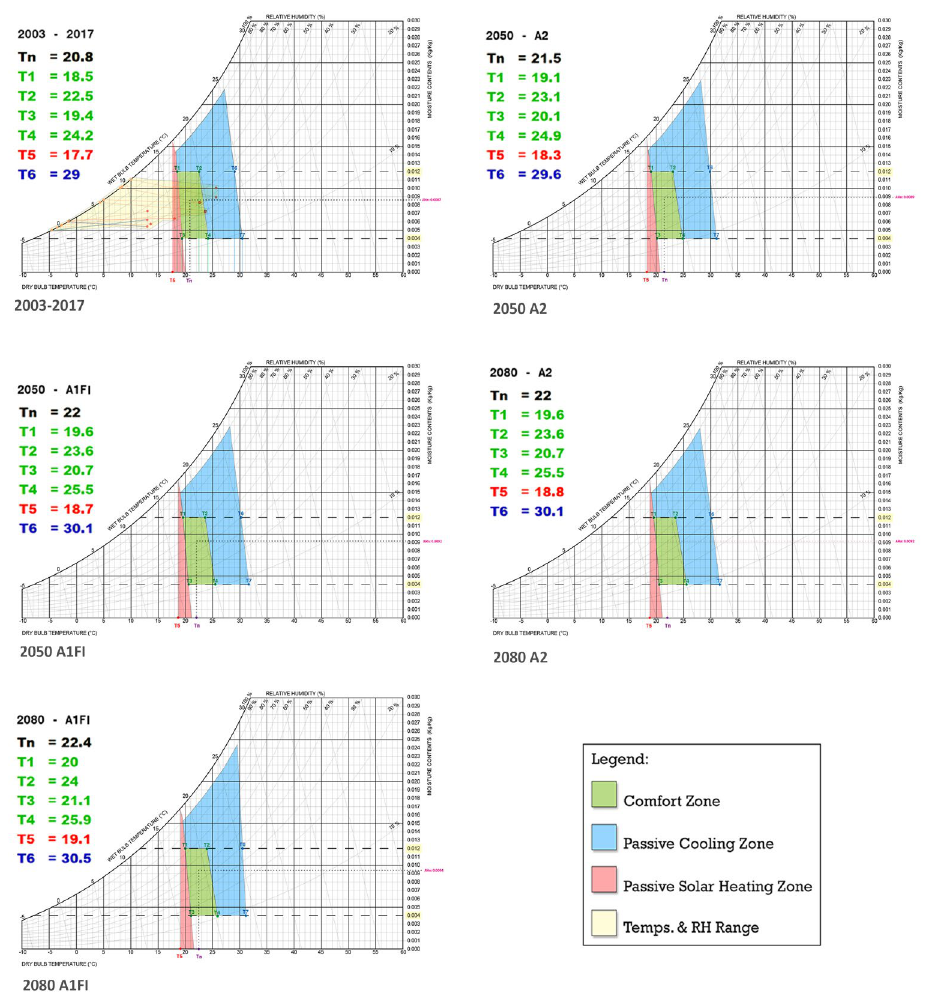
Fig. 6. Psychrometric Charts – Zones